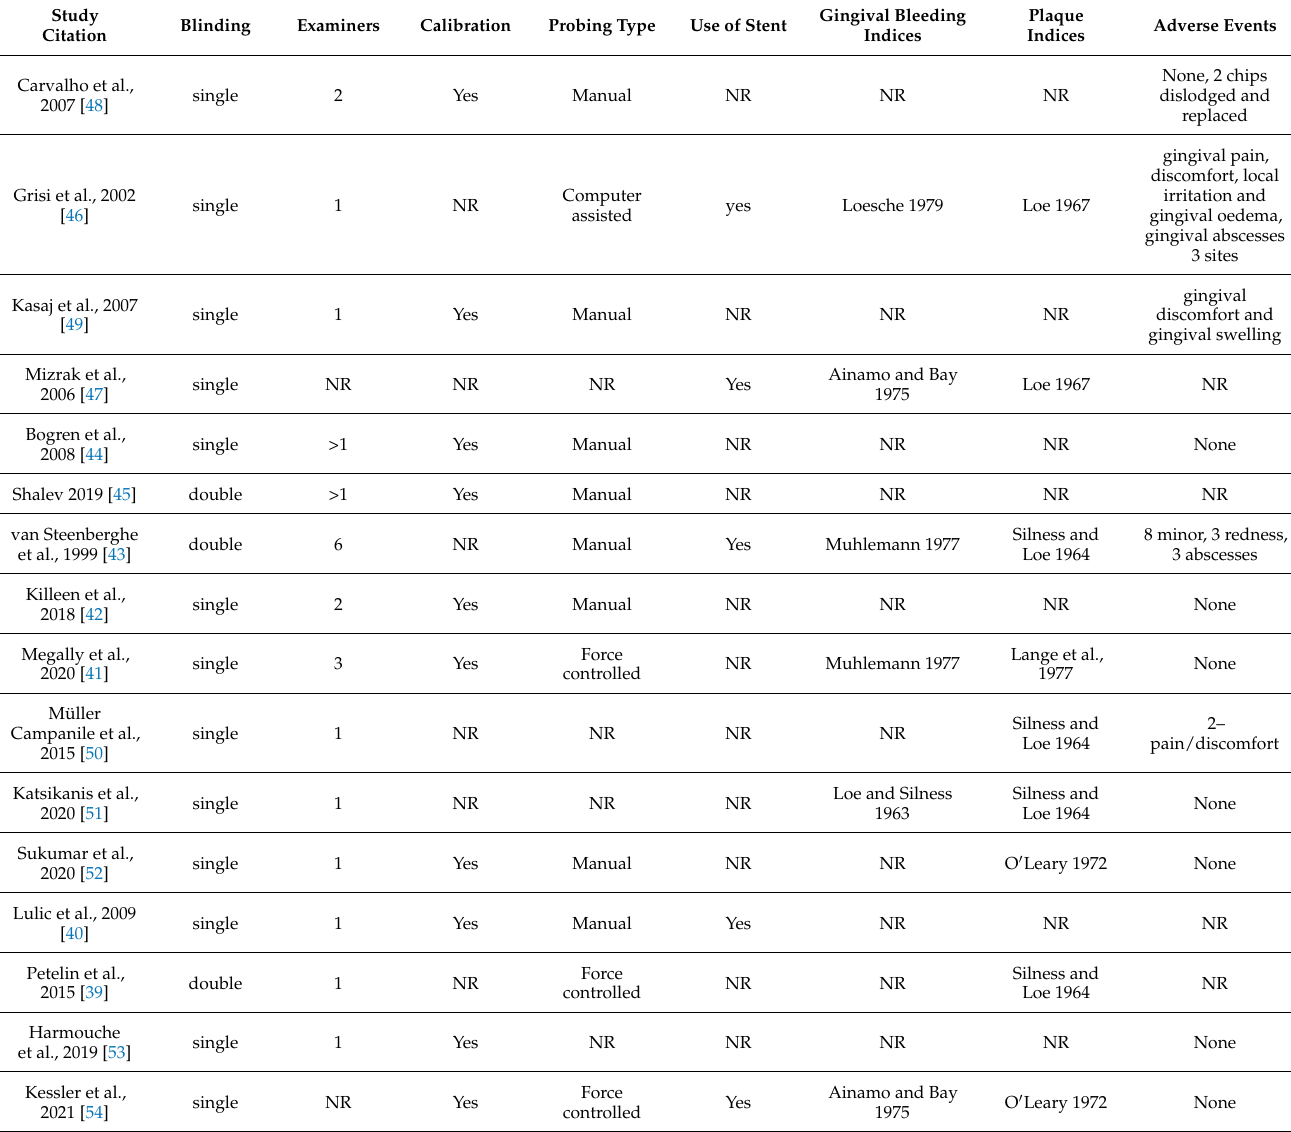
Table 3. Clinical outcome assessment and adverse events of the included